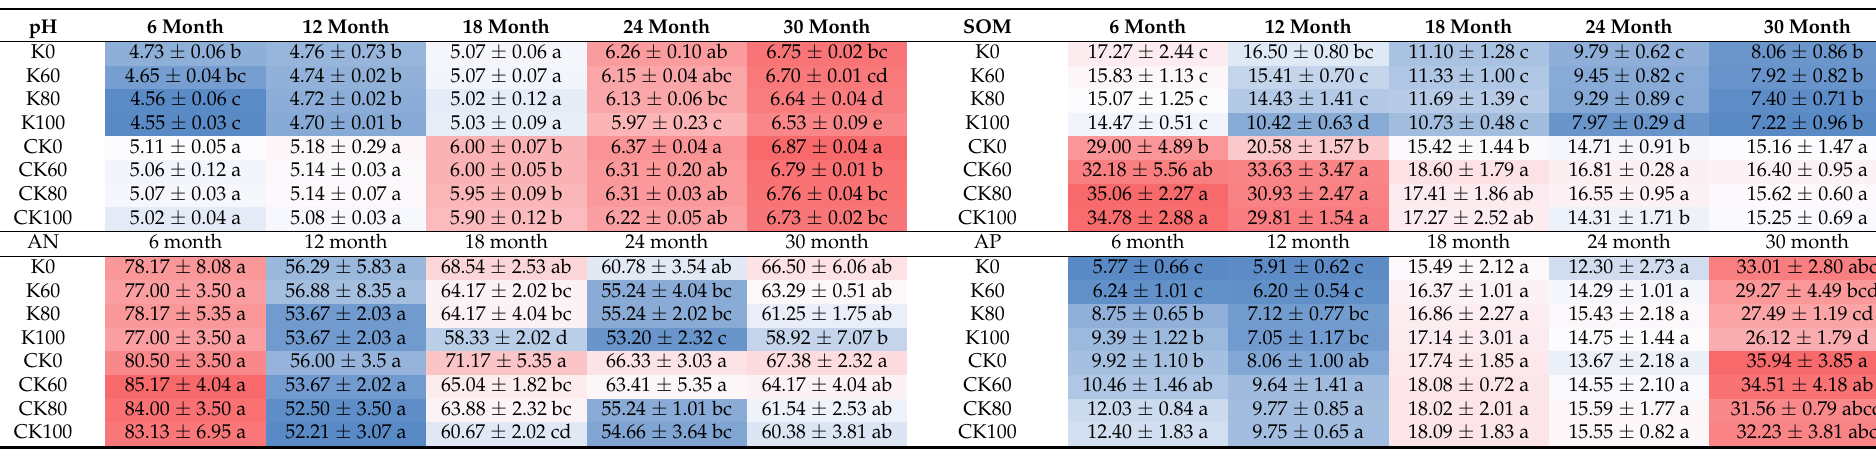
Note: Values show replicate plot means ( n = 3) and the standard error of the mean (S.E.M.). Colored cells denote heatmap visualization of the differences between treatments with column means. Values followed by a different lowercase letter indicate significant differences according to Duncan’s test ( p <